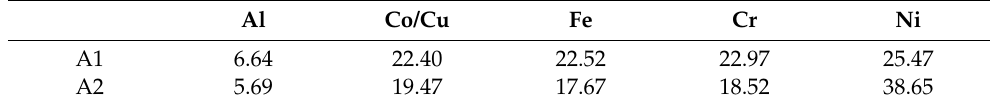
Table 1. Chemical composition (in at%) of A1 and A2 alloys.